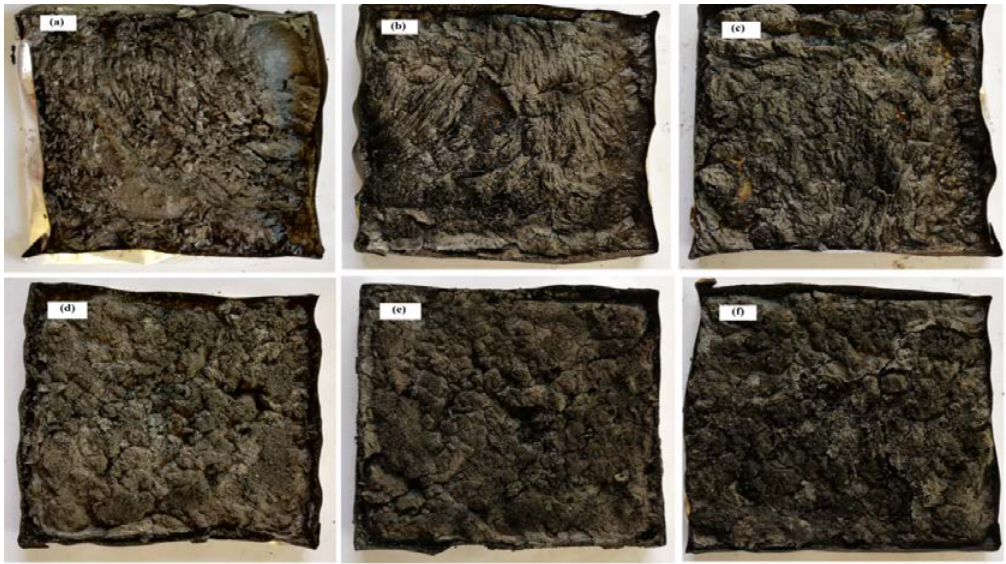
Figure 6. Photographs of the residues of PLA/APP10 ( a ), PLA/APP15 ( b ), PLA/APP20 ( c ), PLA/APP20/ST3 ( d ), PLA/APP20/ST5 ( e ), and PLA/APP20/ST7 ( f ) after cone calorimetry test.